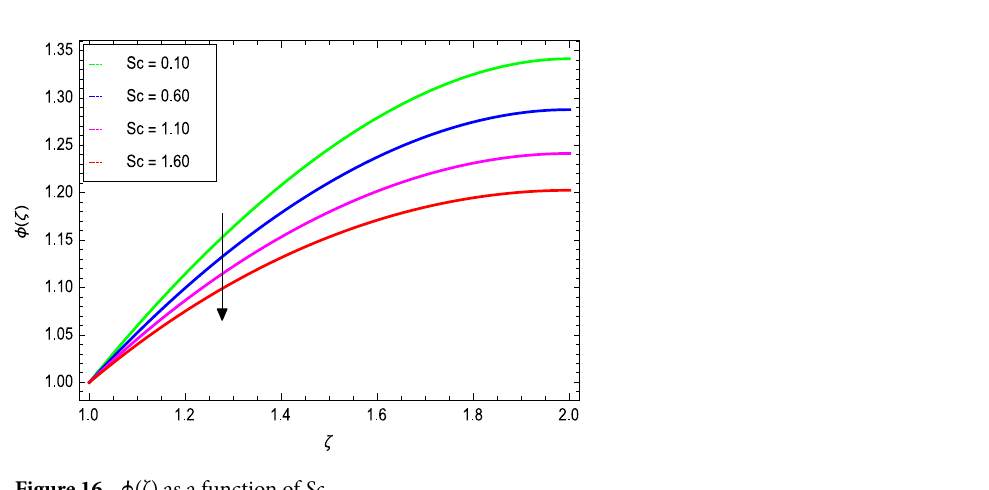
(ζ) as a function of γ 1 . ϕ